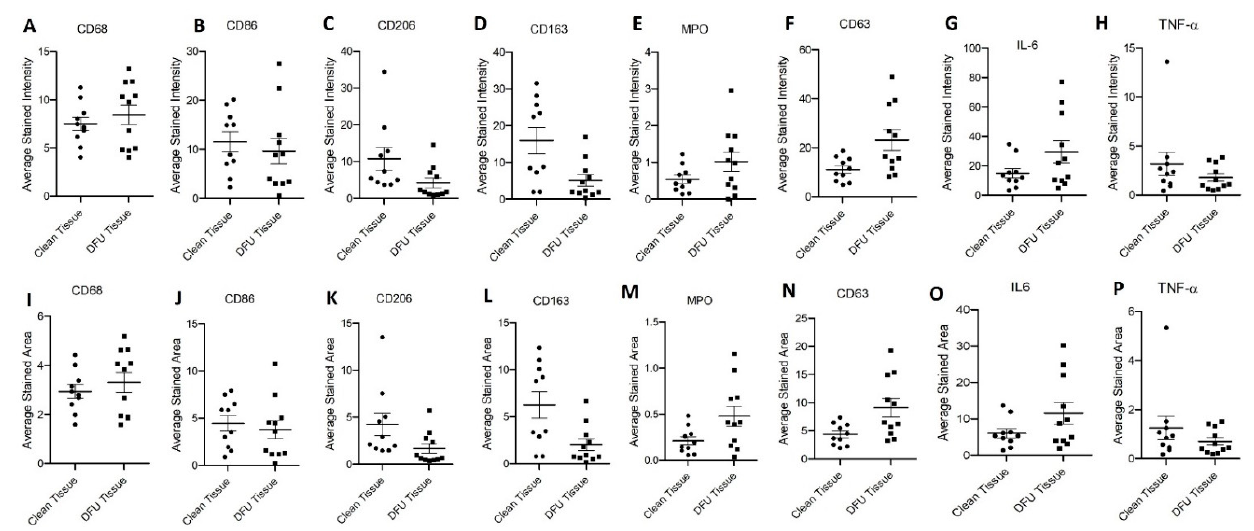
Figure 5. Mean stained intensity for CD68 ( A ), CD86 ( B ), CD206 ( C ), CD163 ( D ), MPO ( E ), CD63 ( F ), IL-6 ( G ), and TNF-( H ) and average stained area for CD68 ( I ), CD86 ( J ), CD206 ( K ), CD163 ( L ), MPO ( M ), CD63 ( N ), IL-6 ( O ), and TNF- α ( P ) in clean and diabetic foot ulcer (DFU) tissues. The data are presented as mean ± SEM ( n = 11 in each group).